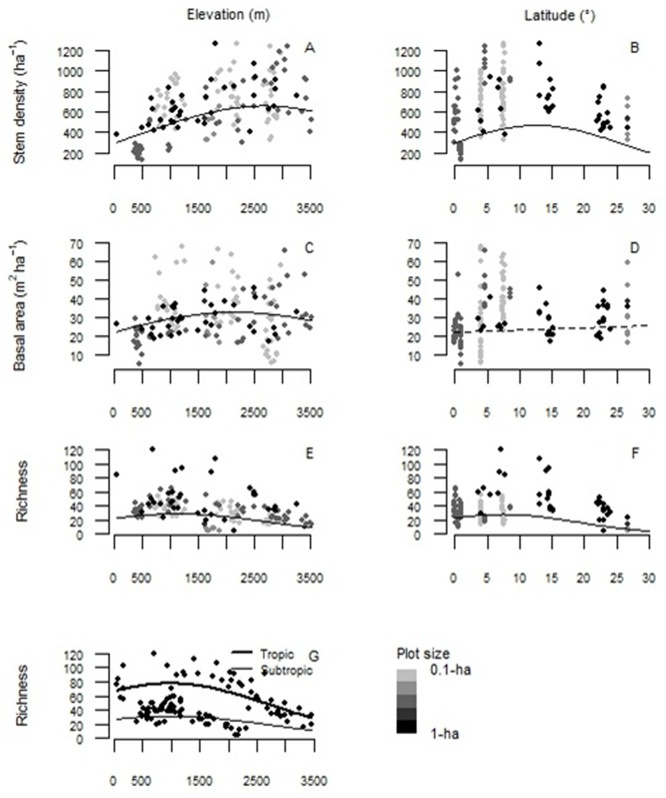
Structural trends of Andean Forest Network plots along elevation and latitudinal gradients.(A-B) Stem density, (C-D) basal area, and (E-G) species richness along Andean Forest Network plots in the elevation and latitudinal (expressed as distance in degrees to equator) gradient, respectively. Plots are differentiated by size with a gray gradient from 0.1-ha (60 plots), 0.24-ha (7 plots), 0.36-ha (49 plots), ~0.5-ha (6 of 0.40-ha and 1 of 0.48-ha) to 1-ha (109 plots of 1-ha, 2 of 0.96-ha, and 1 plot of 6-ha). Solid lines are significant (i.e. p < 0.001).